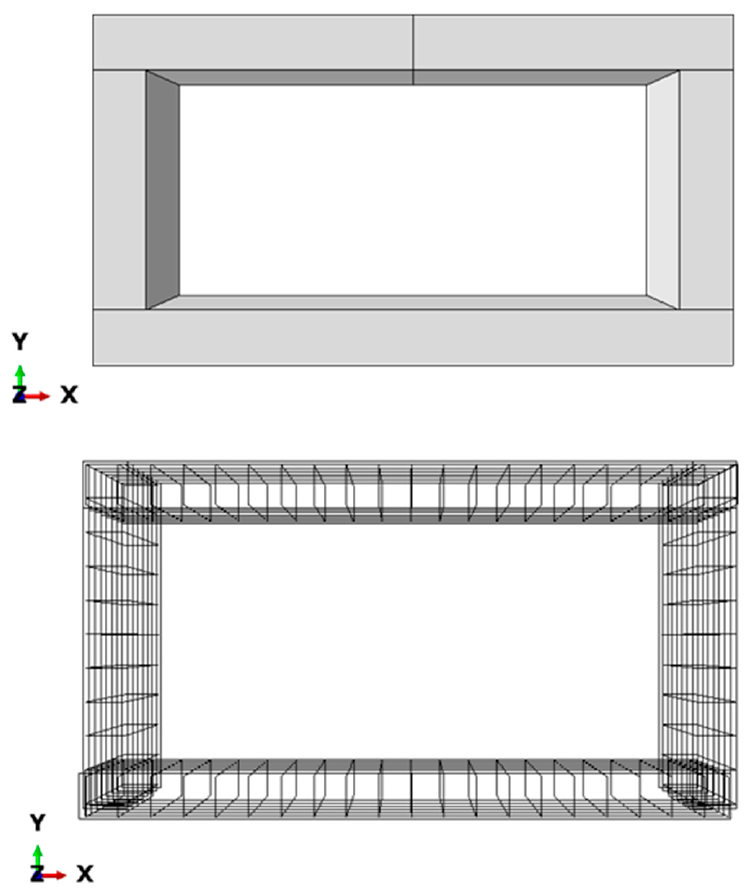
Figure 4. FEM of reinforcement cage and concrete box culvert.